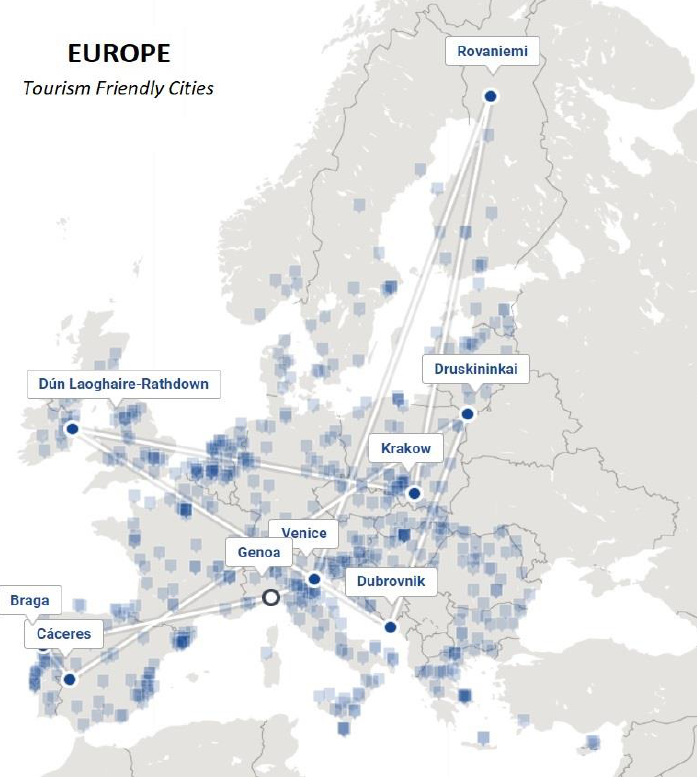
Figure 1. Tourism Friendly Cities. Source: on the basis and with the consent of URBACT [3]. However, cooperation within the partnership takes place not only at the level